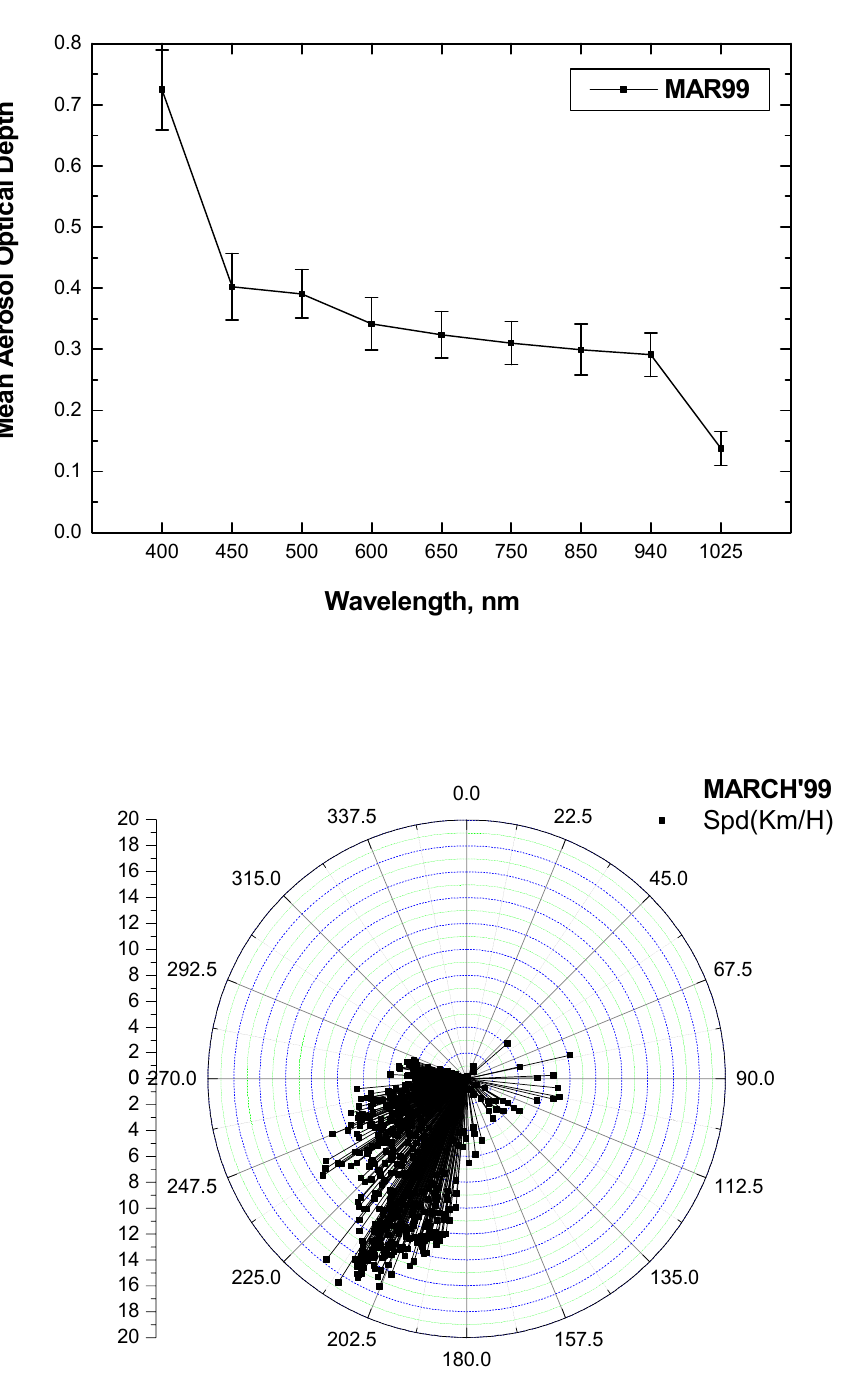
Fig. 6. Same as Fig. 5 for March 1999 when the wind is predominantly south/southwest.